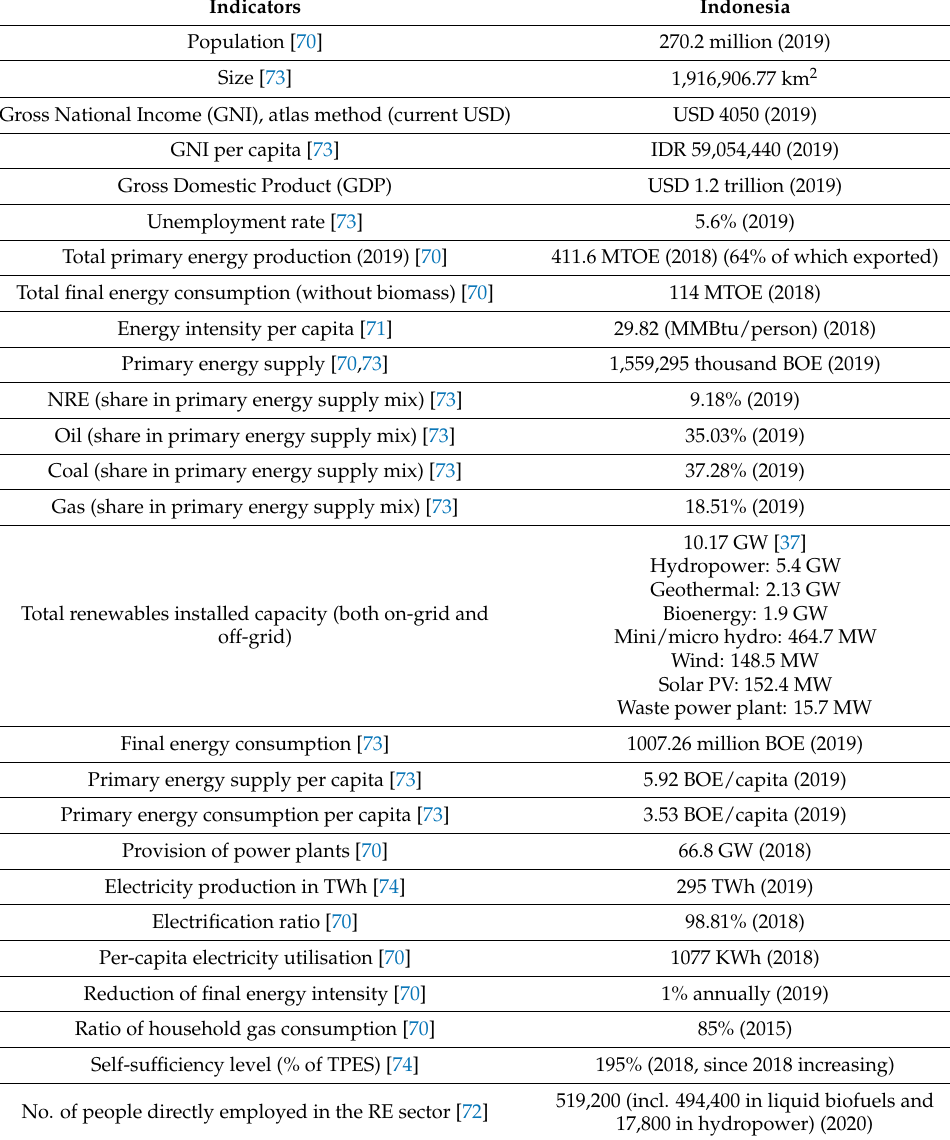
Table A1. Characteristics of the Indonesian Energy System (data sources: DEN [26,70], IEA [8,9,71], IRENA [72], MEMR